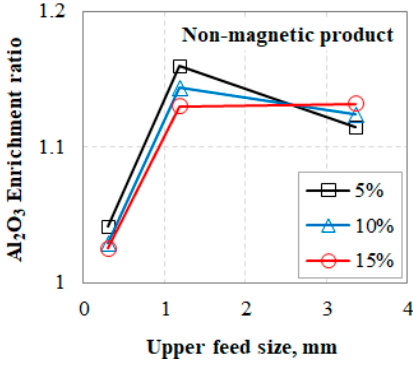
Figure 13. Al 2 O 3 enrichment ratio in the non-magnetic products when different feed fractions were subjected to magnetic separation for various material filling volumes f c .